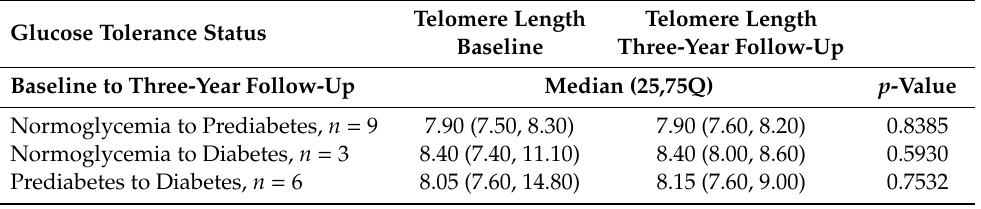
Figure 1. There were no significant differences between the telomere length at Baseline and 3 ‐ year Follow ‐ up as categorized by progression and no ‐ progression; Baseline and Follow ‐ up for subjects who did not progress (N150): Median (range): 7.90 (7.50; 8.40) and 7.90 (7.60; 8.50); for subjects who did progress (N18): 8.10 (7.50; 8.40) and 8.05 (7.60; 8.40); p = 0.3328. Table 2. Telomere length as measured against the progression of the glucose tolerance status from baseline to three ‐ year follow ‐ up.